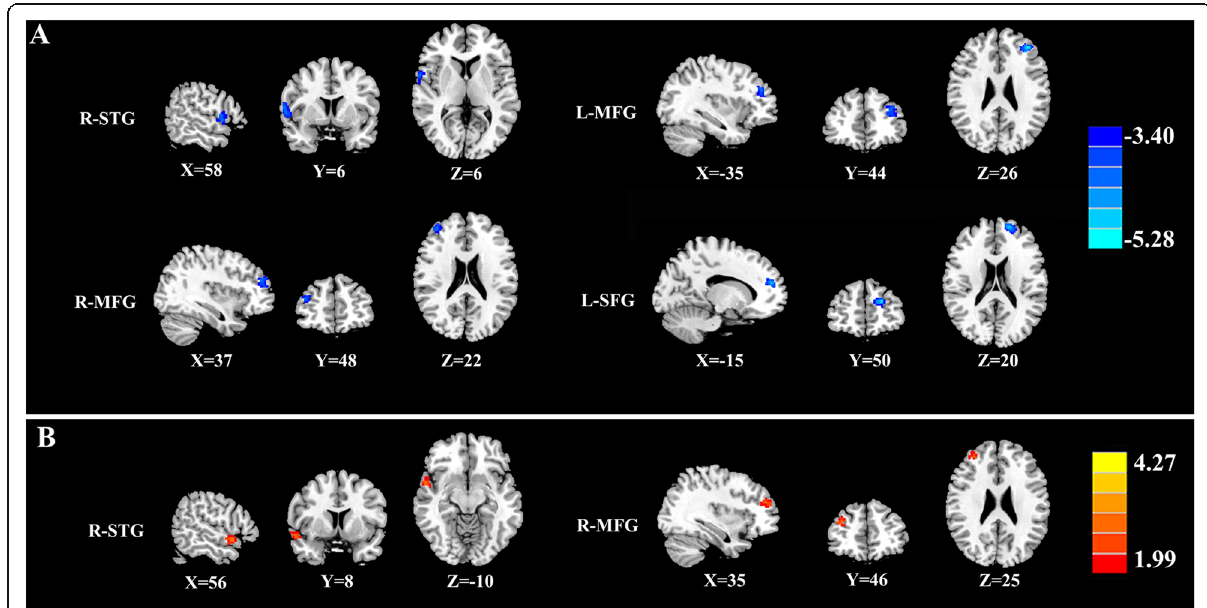
Fig. 2 The rCBF differences between the chronic tinnitus patients and non-tinnitus controls. ( A ) The tinnitus patients exhibited decreased rCBF in the right superior temporal gyrus (STG), left and right middle frontal gyrus (MFG), and left superior frontal gyrus (SFG) ( P < 0.01, FWE corrected); ( B ) The interaction effect of migraine and tinnitus in the right STG and right MFG ( P < 0.01, FWE corrected)